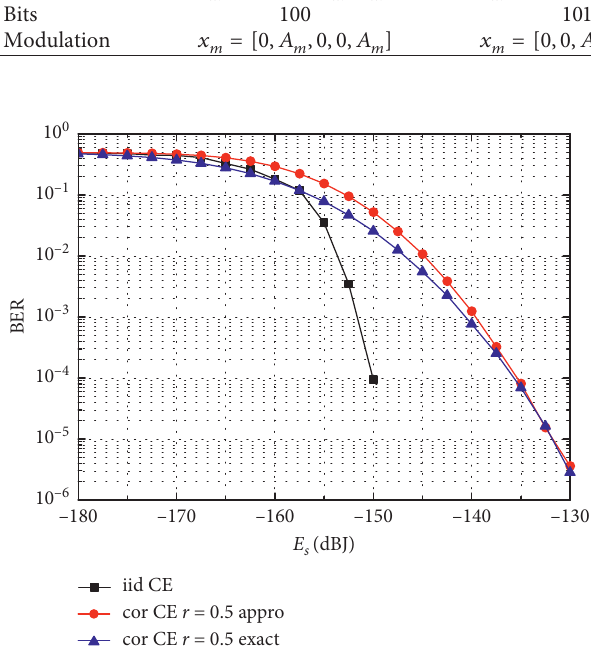
Figure 2: The exact and approximate of BER under combined effects.